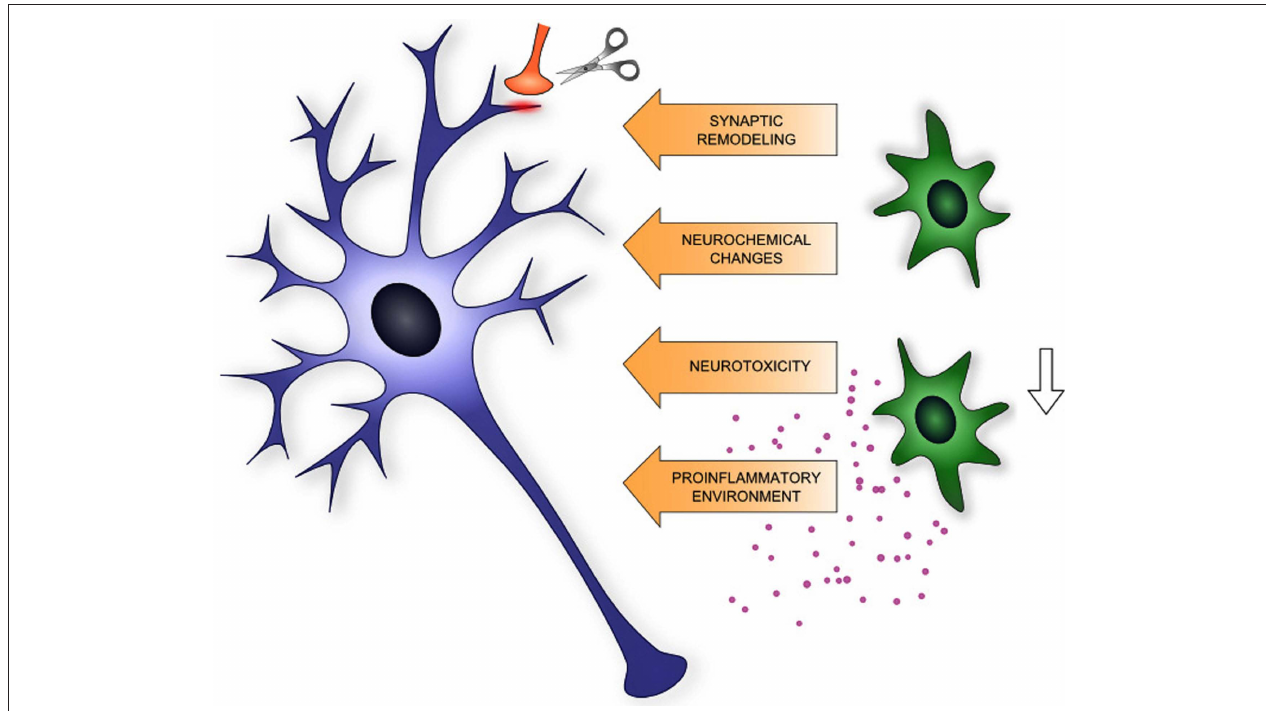
Figure 1 | Schematic summary of microglia (shown in green) – neuron (shown in blue) interaction relevant to neuroplasticity in